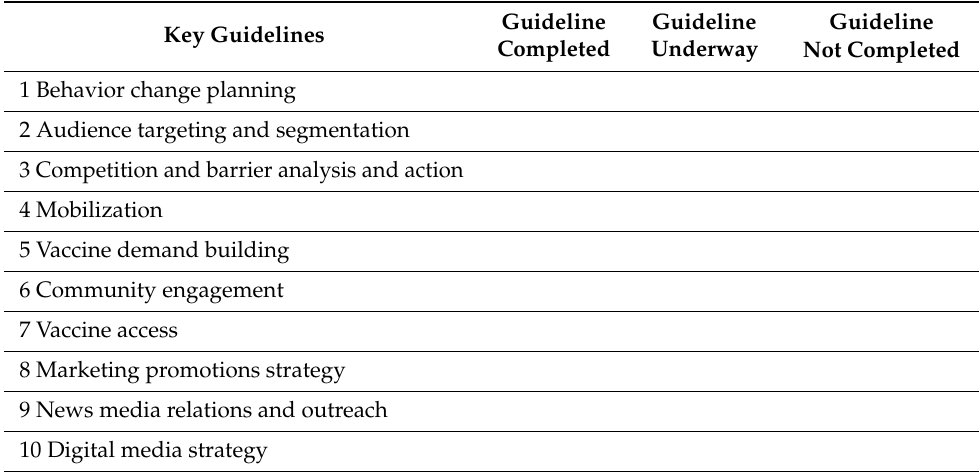
Table 1. Key guidelines for Developing a Proactive COVID-19 Pro-Vaccination